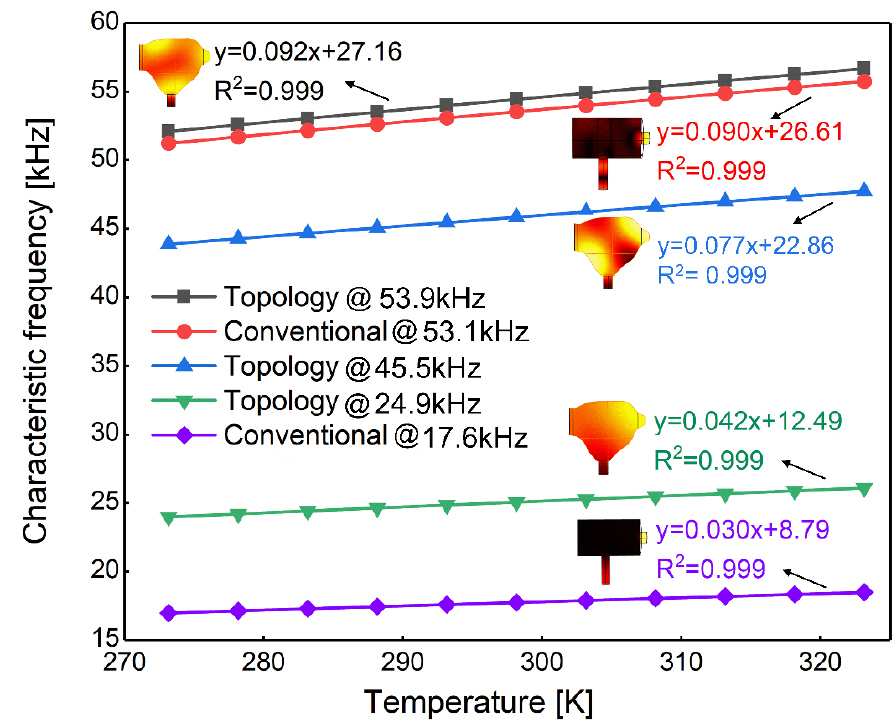
Figure 6. The influence of temperature on the characteristic frequency of two cells .